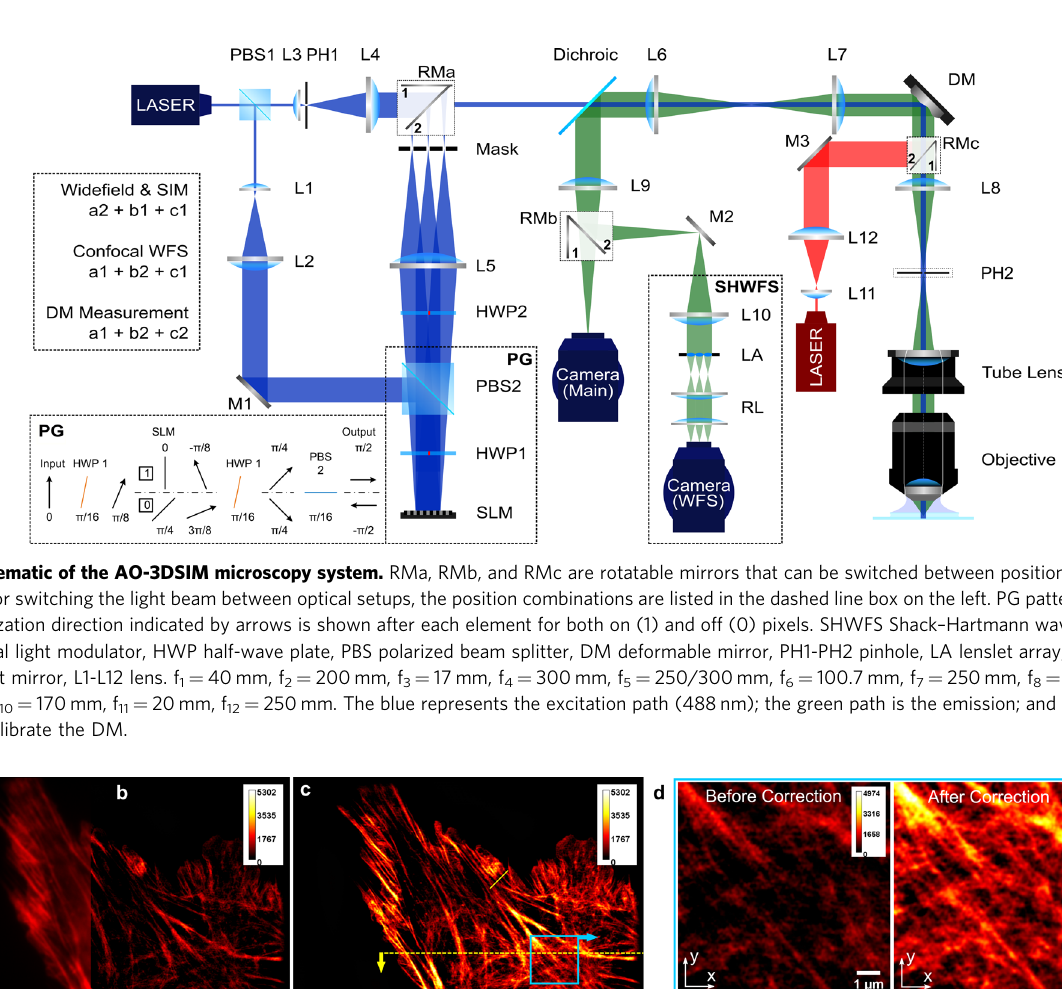
image plane to ensure a diffraction limited focal spot for confocal illumination. Pinhole 2 is placed at the fi rst image plane to block the out-of-focus light when running the SHWFS with confocal illumination. We implemented 3D-SIM as developed by Gus- tafsson et al. 13 and applied image-based sensorless AO, confocal sensorless AO, and direct wavefront sensing AO methods for sample-induced aberration correction. Image-based sensorless AO-3DSIM . We fi rst applied sensorless AO on tissue culture cells ( α -TN4 lens epithelial cells on a #1.5 glass coverslip) to demonstrate the correction of system